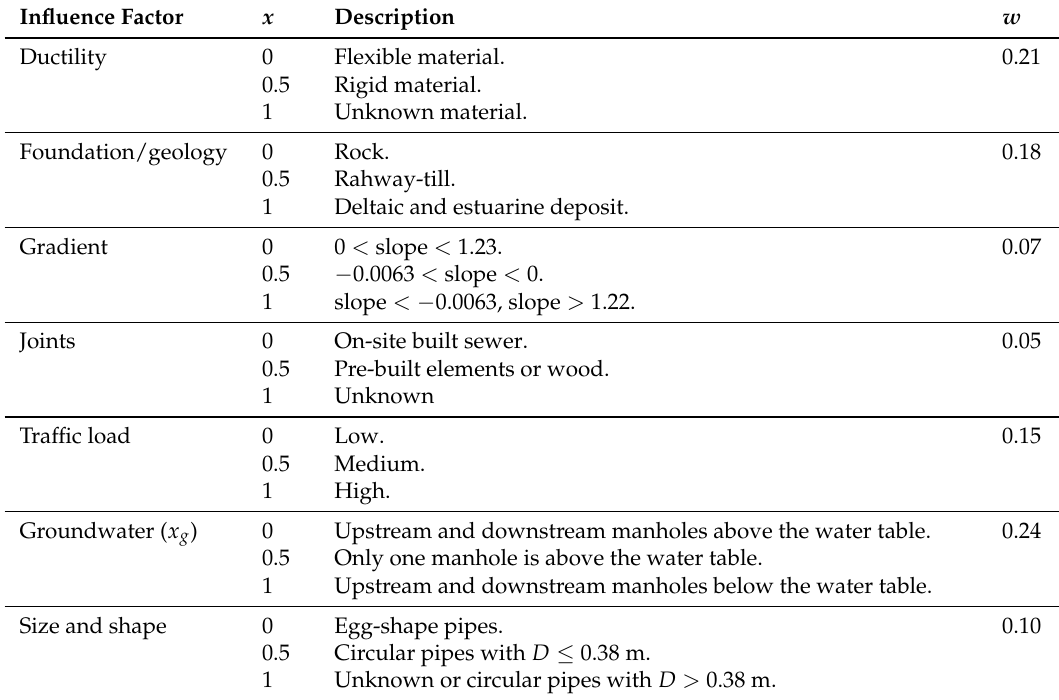
Table 1. Influence factors of structural damage of a sewer. The symbols x and w are the likelihood of failure and the relative weight